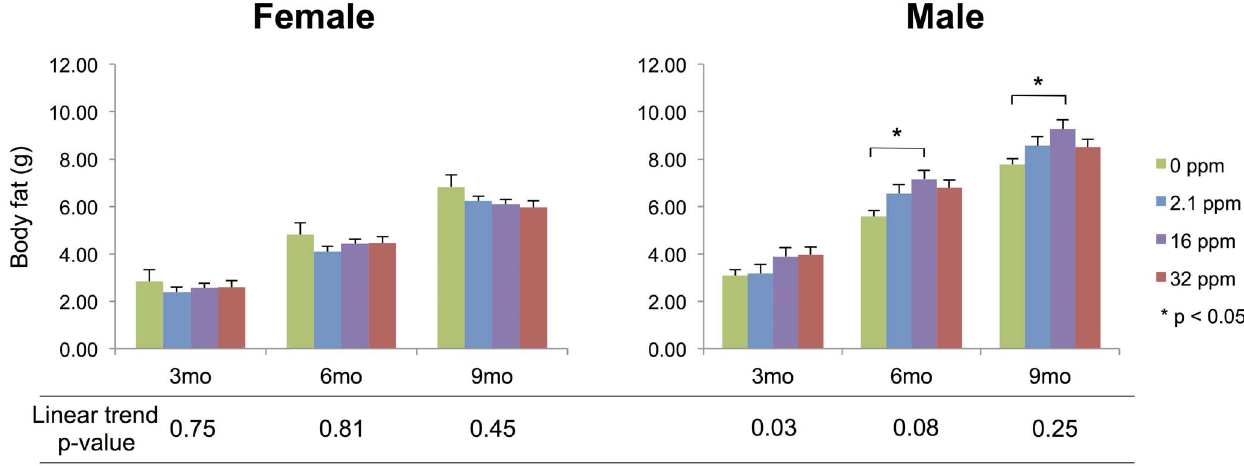
Figure 4. Body Fat. Measured by nuclear magnetic imaging. Females show no linear trend with exposure level. Males show a significant trend of increasing body fat with dose at 3 months, and near significance at 6 months. Stars indicate p-values , 0.05 as compared to control offspring.